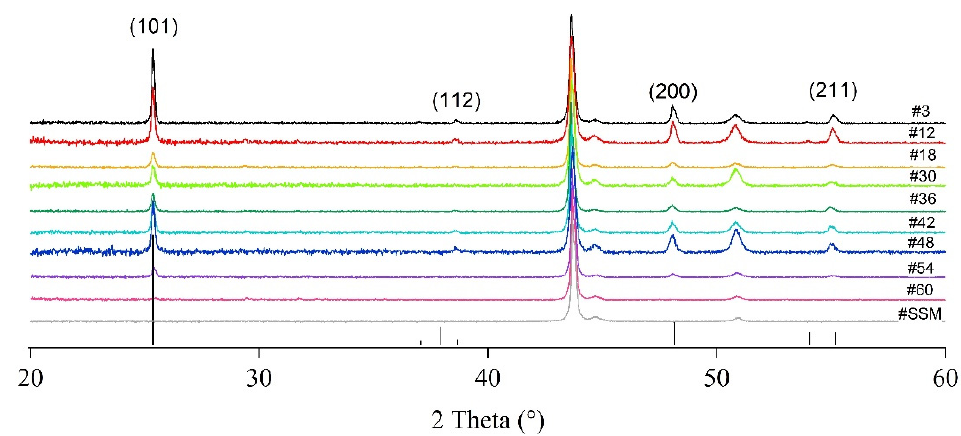
Figure 6. XRD patterns for the bare SSM and the different portions of the TiO 2 -SSM. The anatase TiO 2 pattern (black vertical bar, ICDD #01-073-1764) is also reported for comparison. For all the deposited layers, the Lotgering factor (F 200 ) is estimated from the XRD pat- terns recorded at RT by considering the reflections in the 2 θ range 20°–60°. The F 200 factors calculated are listed in Table 1. The maximum F 200 calculated value is 0.2, while the modal value is 0.1, which indicates a general poor (200) preferential orientation